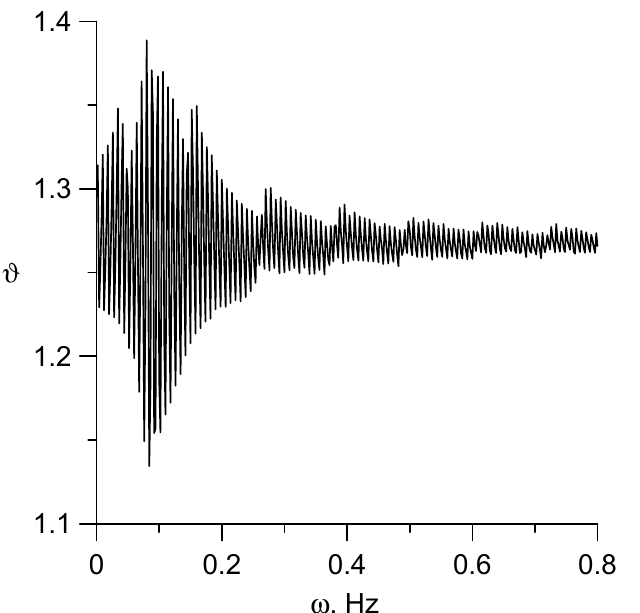
Figure 10. The local temperature ϑ as function of angular velocity of rotation of the screw at the point ξ = 0.8, θ = 0°, ζ = 0.5, Fo = 0.5 for φ 0 = 73.68° and v 0 = 5.89 × 10 − 4 m/s (Fo v = 0.593).